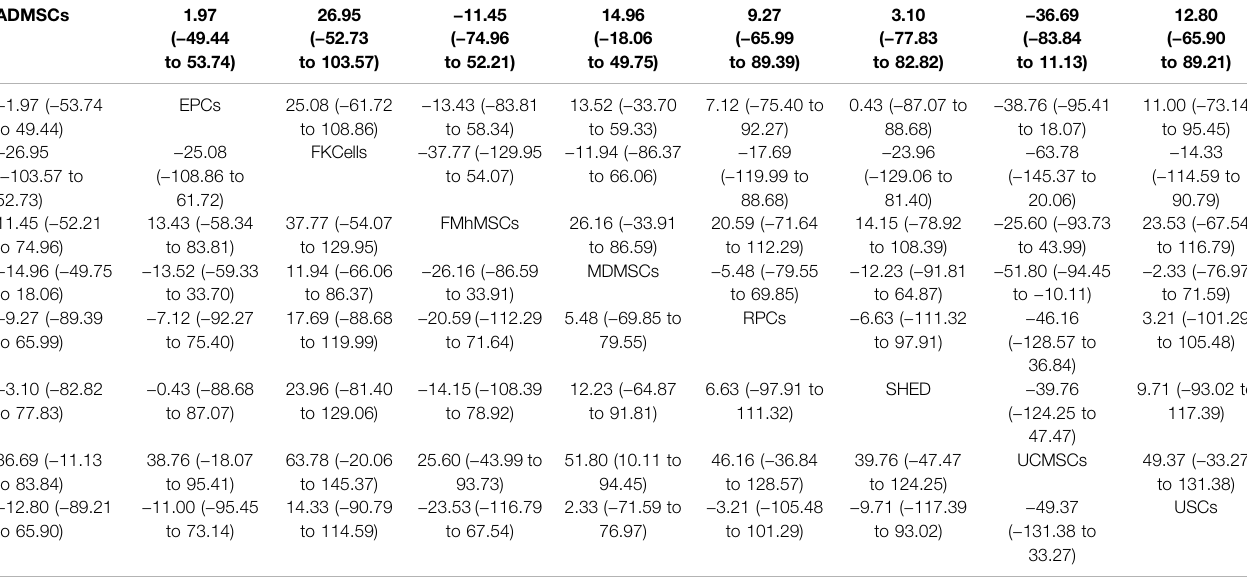
TABLE 8 | Network Meta-analysis results of blood urea nitrogen levels in stem cell groups at 1 day after administration. ADMSCs